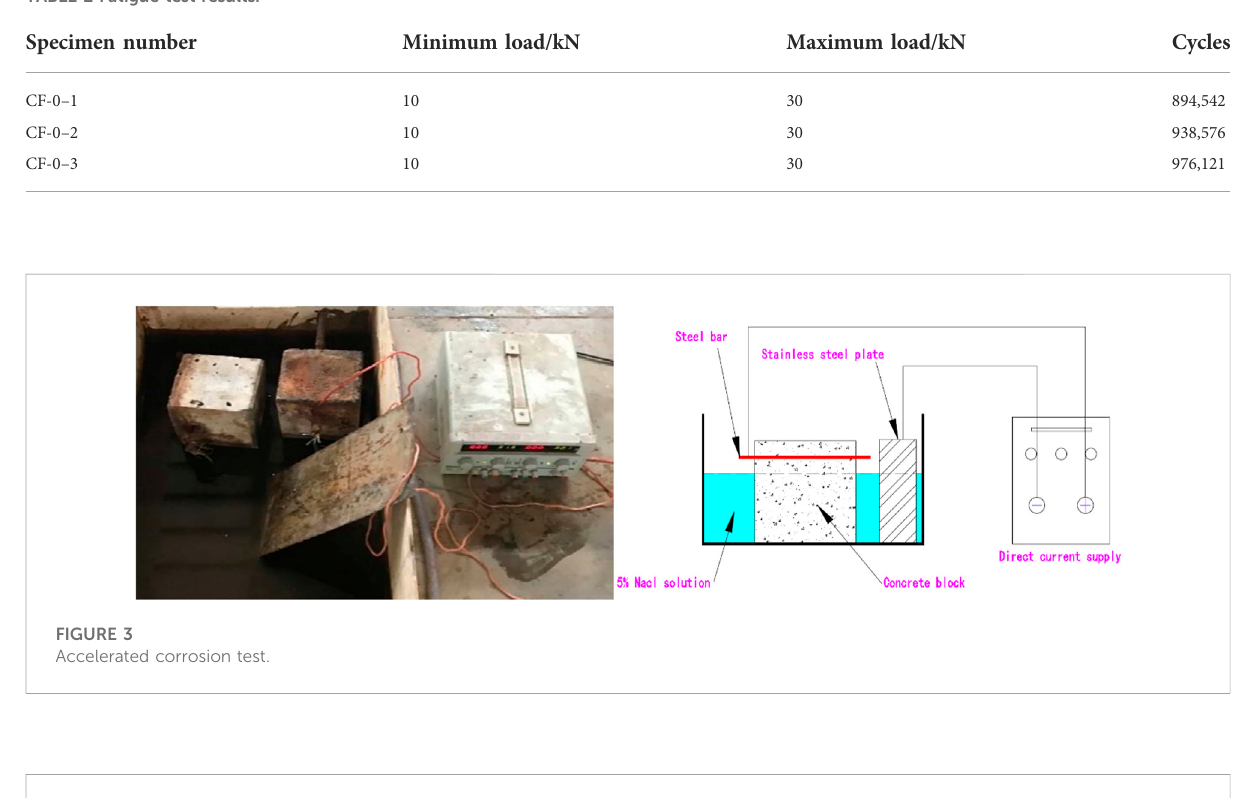
TABLE 2 Fatigue test results.